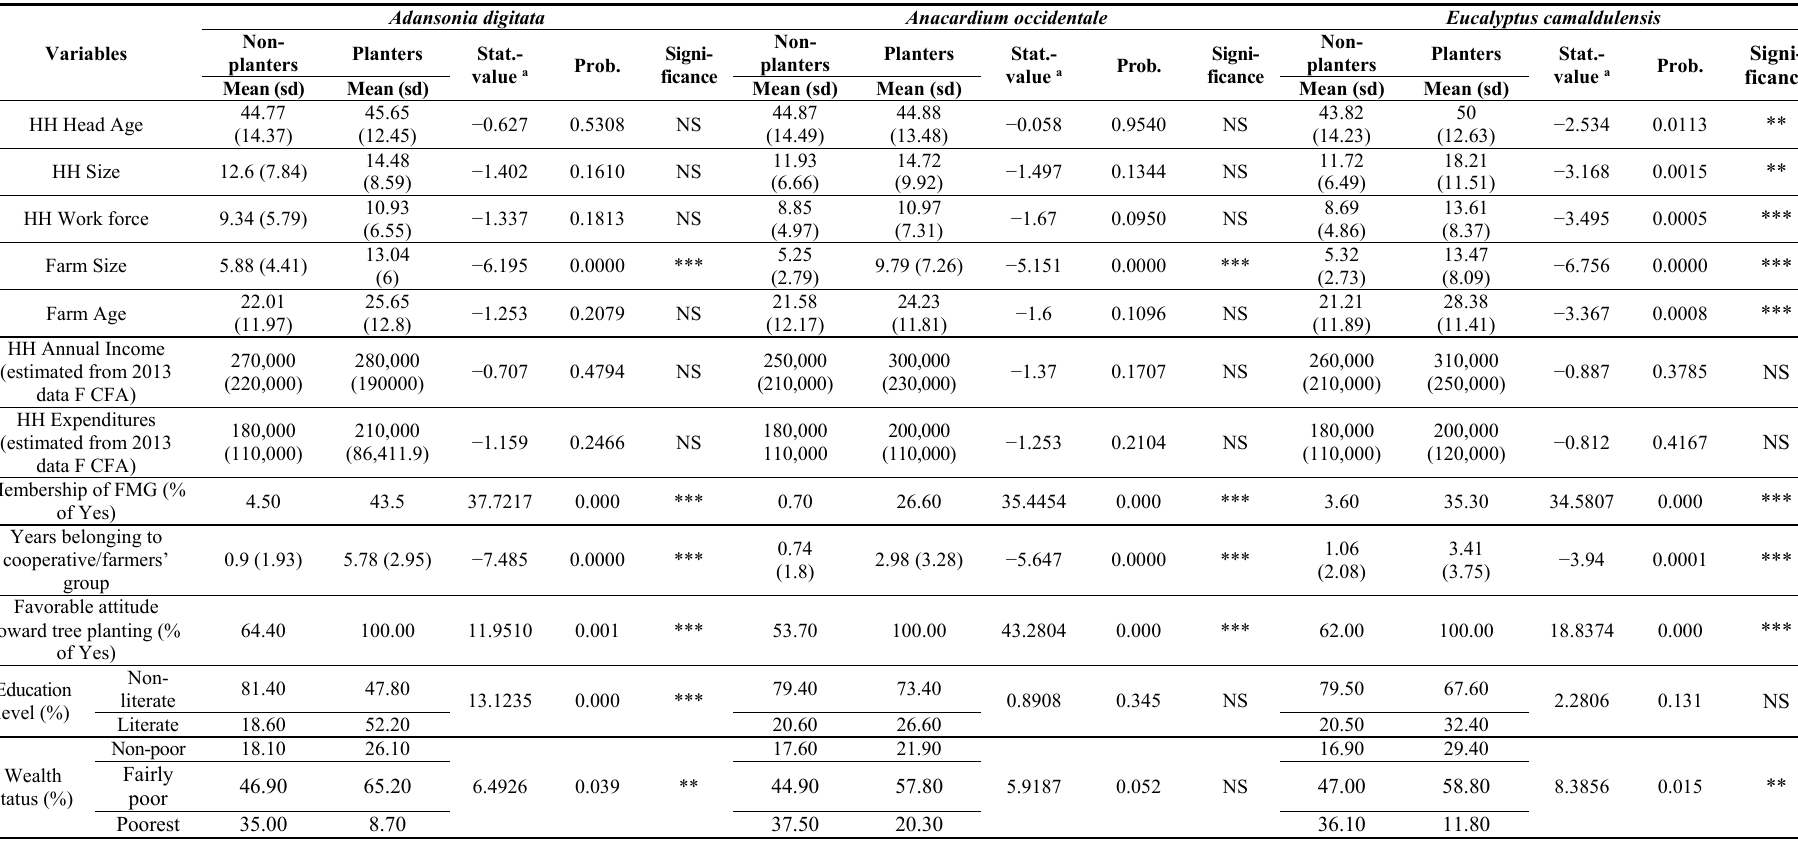
Table 2. Socio-economic and perceptional characteristics between Adansonia digitata planters ( n = 23) and non-planters ( n = 177), Anacardium occidentale planters ( n = 64) and non-planters ( n = 136), Eucalyptus camaldulensis planters ( n = 34) and non-planters ( n = 166). Adansonia digitata Anacardium occidentale Eucalyptus camaldulensis Variables